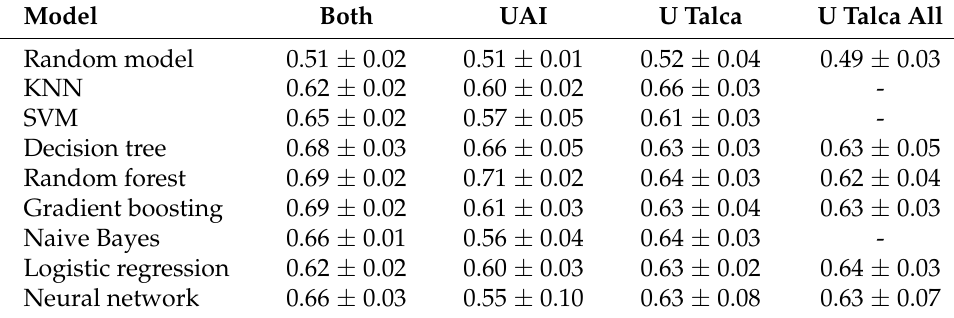
Table 6. Accuracy, for each